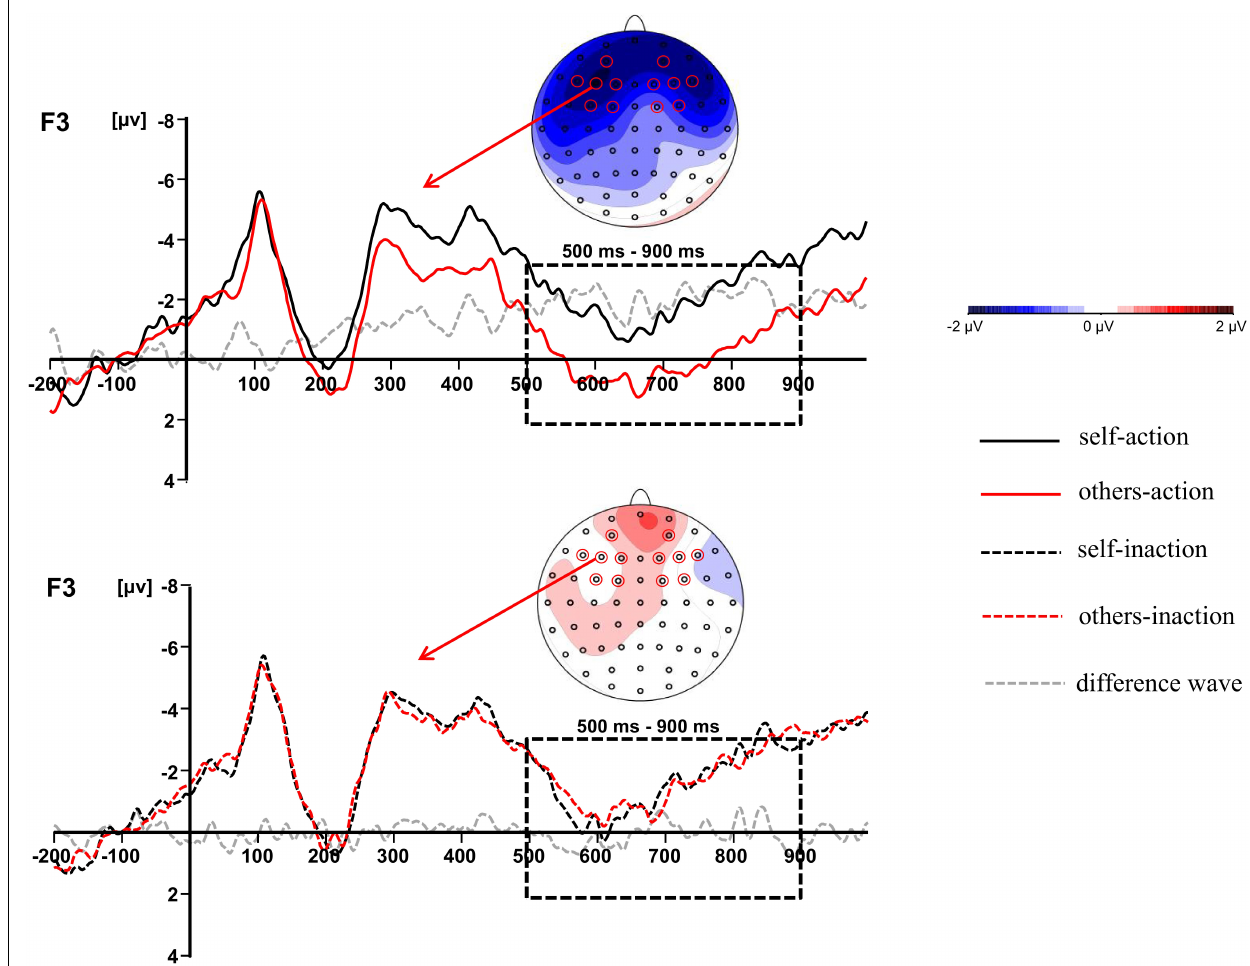
FIGURE 3 | The difference waves at F3 and topographic maps of difference waves for LPC (500–900 ms): other-action condition subtracted from self-action condition ( top panel ), and other-inaction condition subtracted from self-inaction condition ( bottom panel